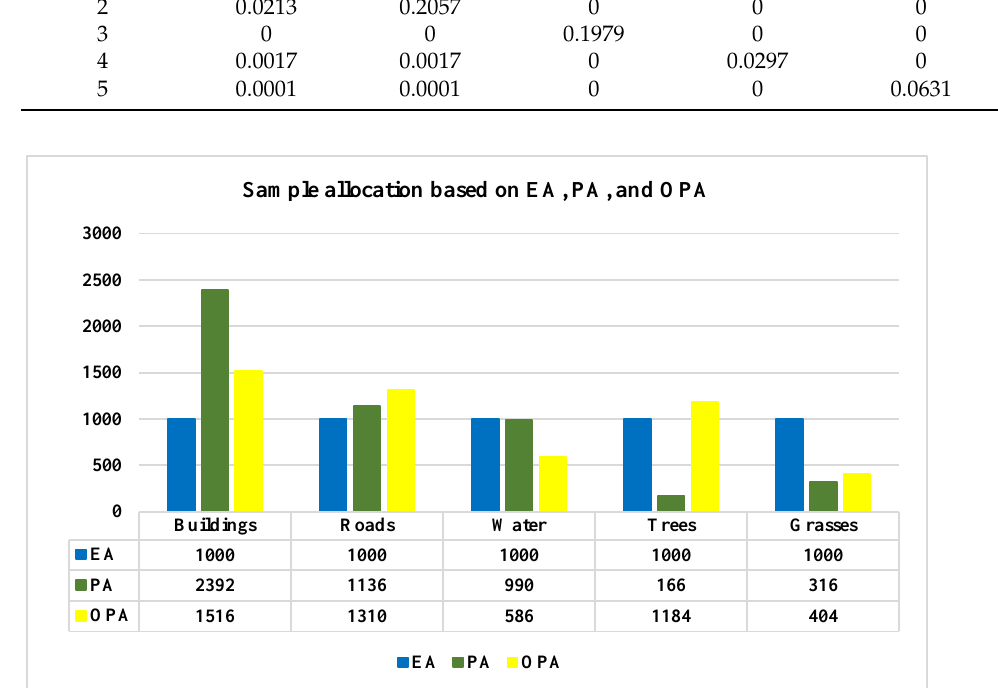
Figure 5. Sample allocation based on the three different methods.